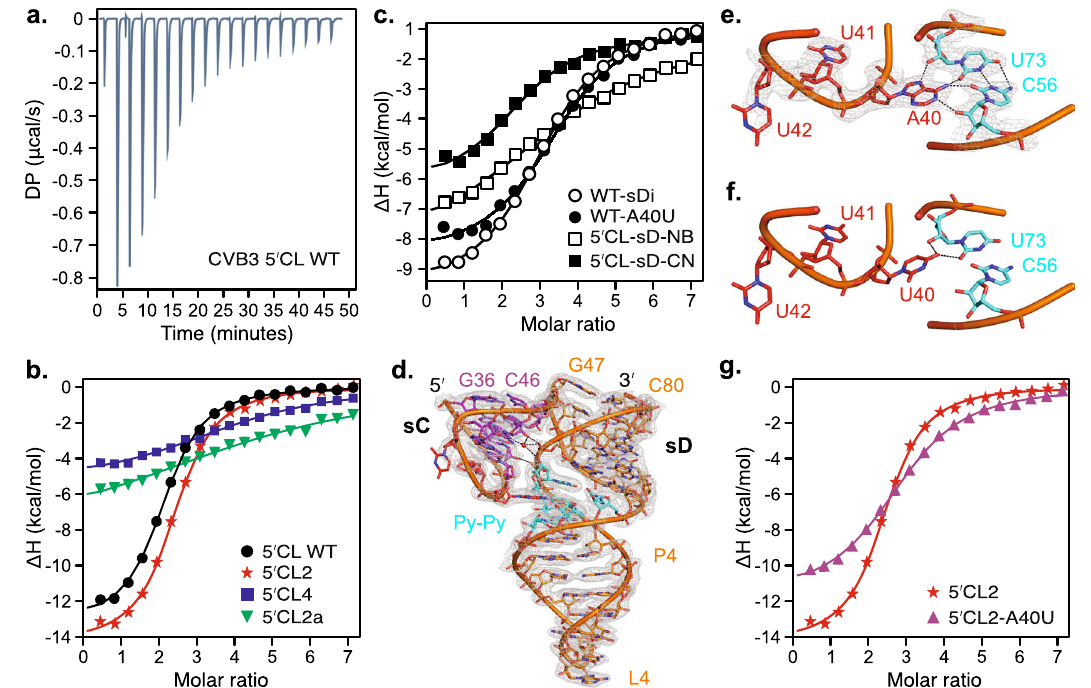
Fig. 4 | Structure ofCVB35 ′ CL sD subdomain and itsbinding interactions with 3Cprotein.a RepresentativeITCpro fi lefortheWT5 ′ CL.Theheatisreleasedupon successive injections of 2 µ l of CVB3 3C (~400 µ M) to the RNA solution (~10 µ M) in thecalorimetrycell. b , c ThebindingcurvesfromtheITCdataforthebindingofthe 3C with various crystallization RNA constructs (see Supplementary Fig. 13, 14, and 15 for details). d Structure of the CVB3 5 ′ CL2a, showing the tertiary interactions betweenthesCandsDsubdomains,especiallythedockingofthesC-loopA40into the Py-Py region of the P4 helix within the sD subdomain. e The details of A-minor